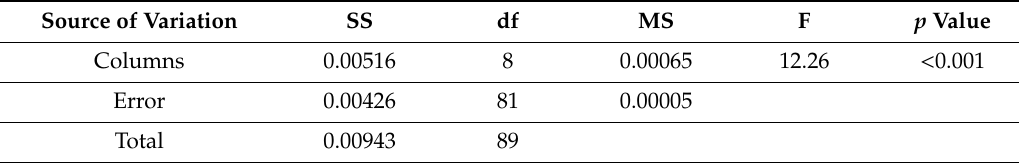
Table 6. One-way analysis of variance test details for the ensemble classifiers.